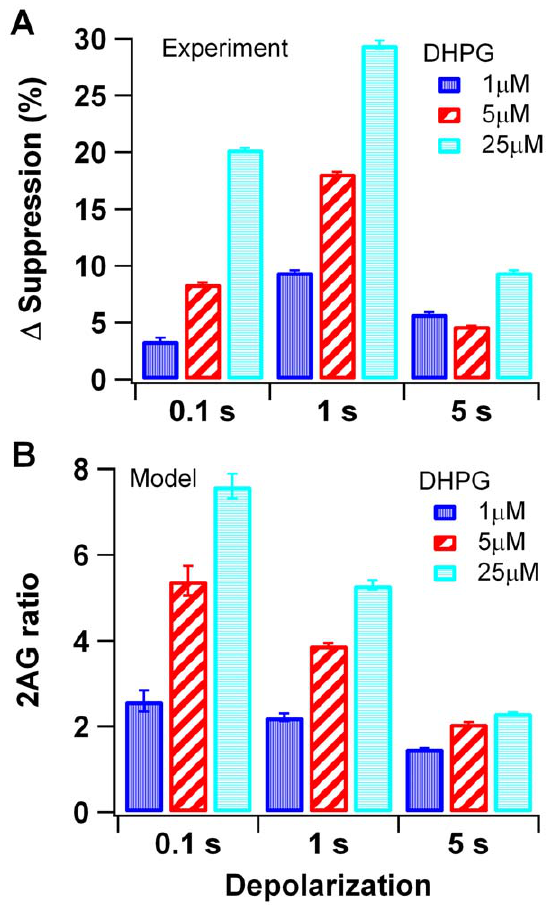
Figure 3. DHPG concentration-dependent enhancement of DSI and 2AG production. (A) Experimental results replotted from Uchigashima et al. J. Neurosci. 2007. The enhancement of suppression was calculated as the change in the magnitude of DSI with DHPG application relative to the suppression without DHPG. (B) Simulation results. Mean and standard error calculated from 3 simulations repeated with different random number seeds. The enhancement of 2AG production is calculated as the ratio of mean 2AG in response to DHPG + calcium divided by 2AG in response to calcium alone. Simulations show that endocannabinoid production in the model is strongly facilitated when calcium influx into the spine and Gq coupled receptor activation are combined. This result matches experimental data in which DSI experiments show that depolarization synergizes with Gq coupled receptor activation.